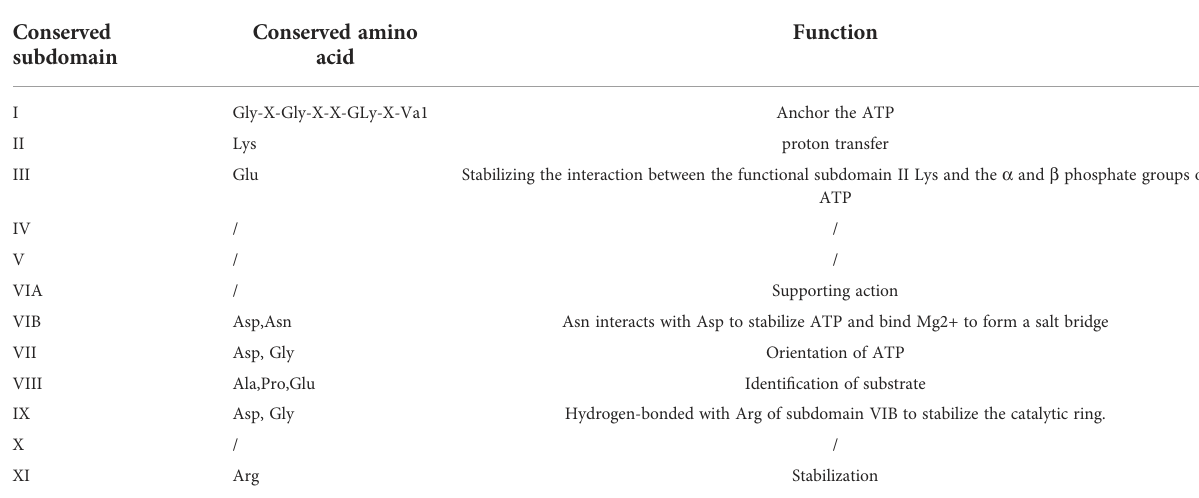
TABLE 1 The Protein kinase catalytic